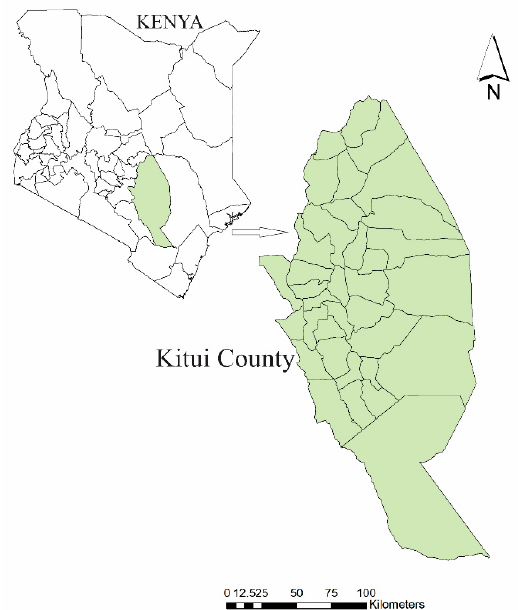
Figure 1. Map of Kenya showing the location of Kitui county.